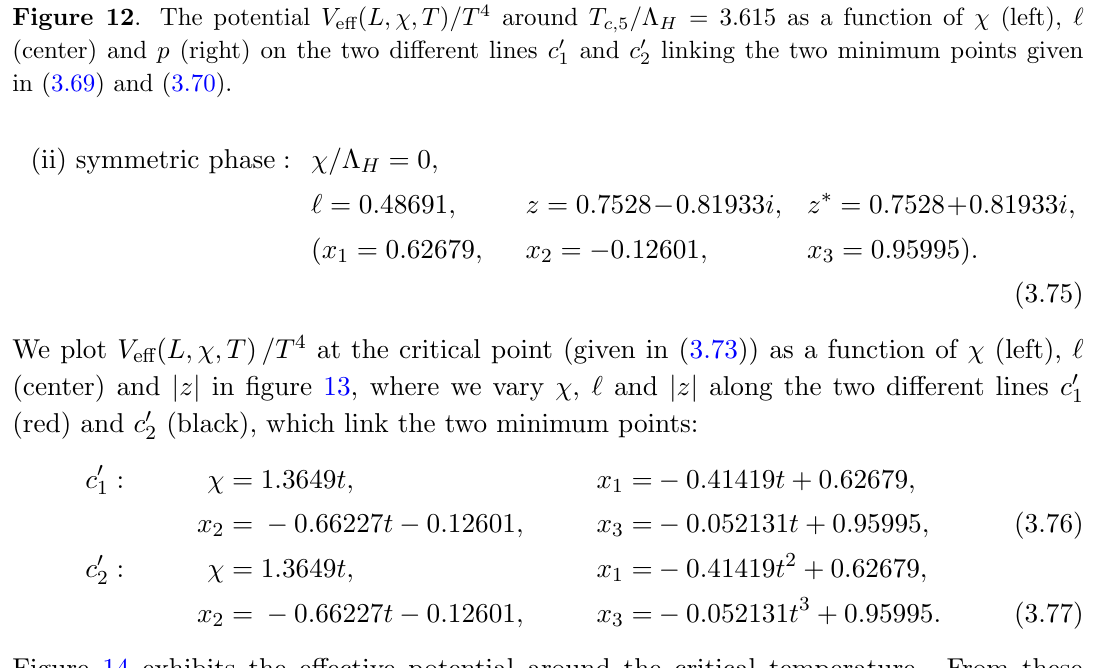
Figure 14 exhibits the e(cid:11)ective potential around the critical temperature. From these (cid:12)gures we conclude that the scale phase transition for N = 6 with the Polyakov loop e(cid:11)ect included is a (cid:12)rst-order phase